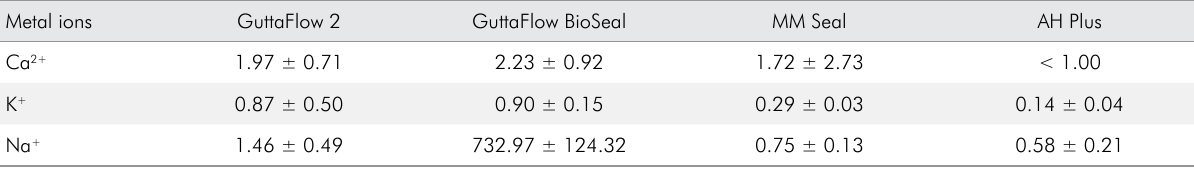
Table 3. Metal solubility (mg/L) of root canal sealers determined by atomic absorption